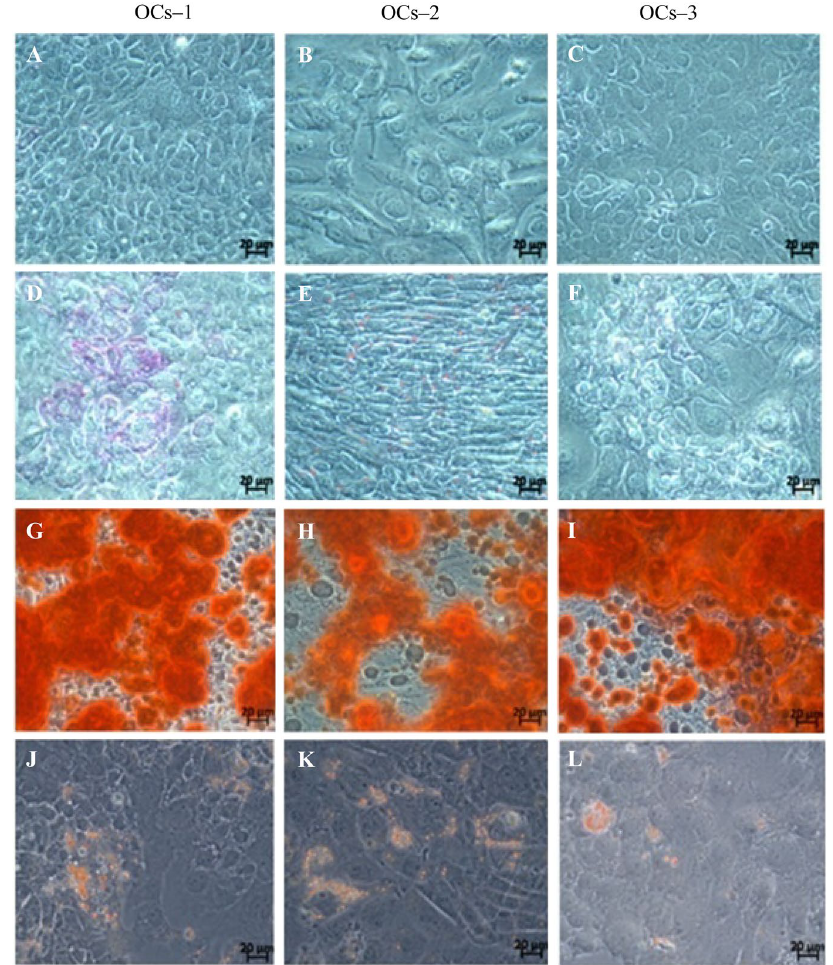
Figure 2. Differentiation towards hepatic, osteogenic and adipogenic lineages of three oval cell lines (OCs-1, OCs-2 and OCs-3). ( A – C ) Controls of OCs-1, OCs-2 and OCs-3, ( D – F ) PAS staining for liver differentiation, ( G – I ) Alizarin Red S staining for osteogenic differentiation and ( J – L ) Oil Red staining for adipogenic differentiation. Objective 63